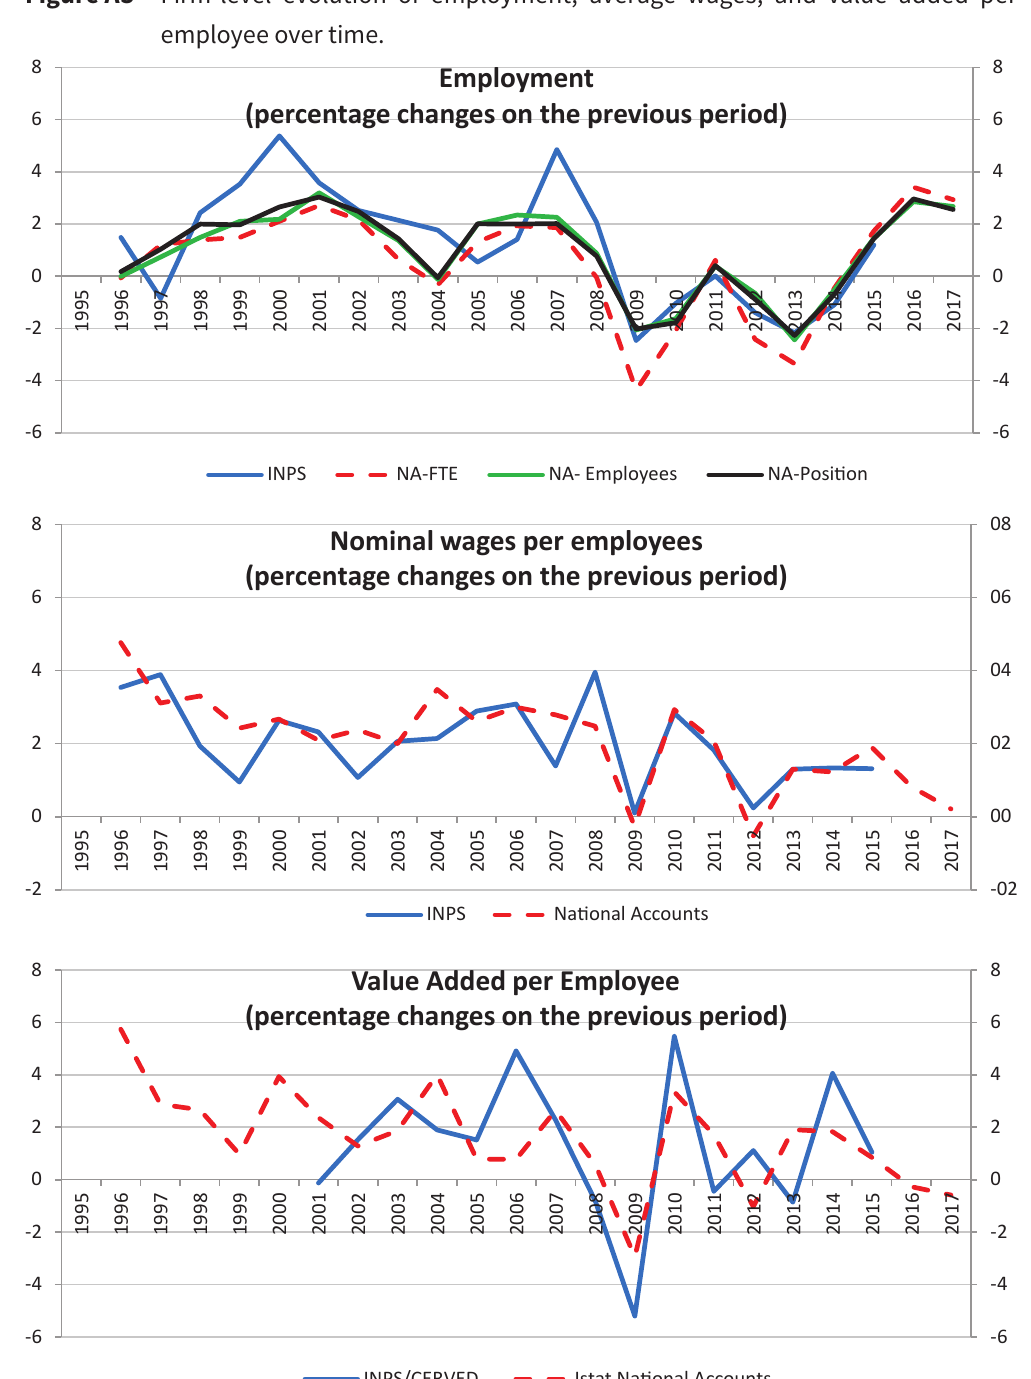
Figure A3 Firm-level evolution of employment, average wages, and value added per employee over